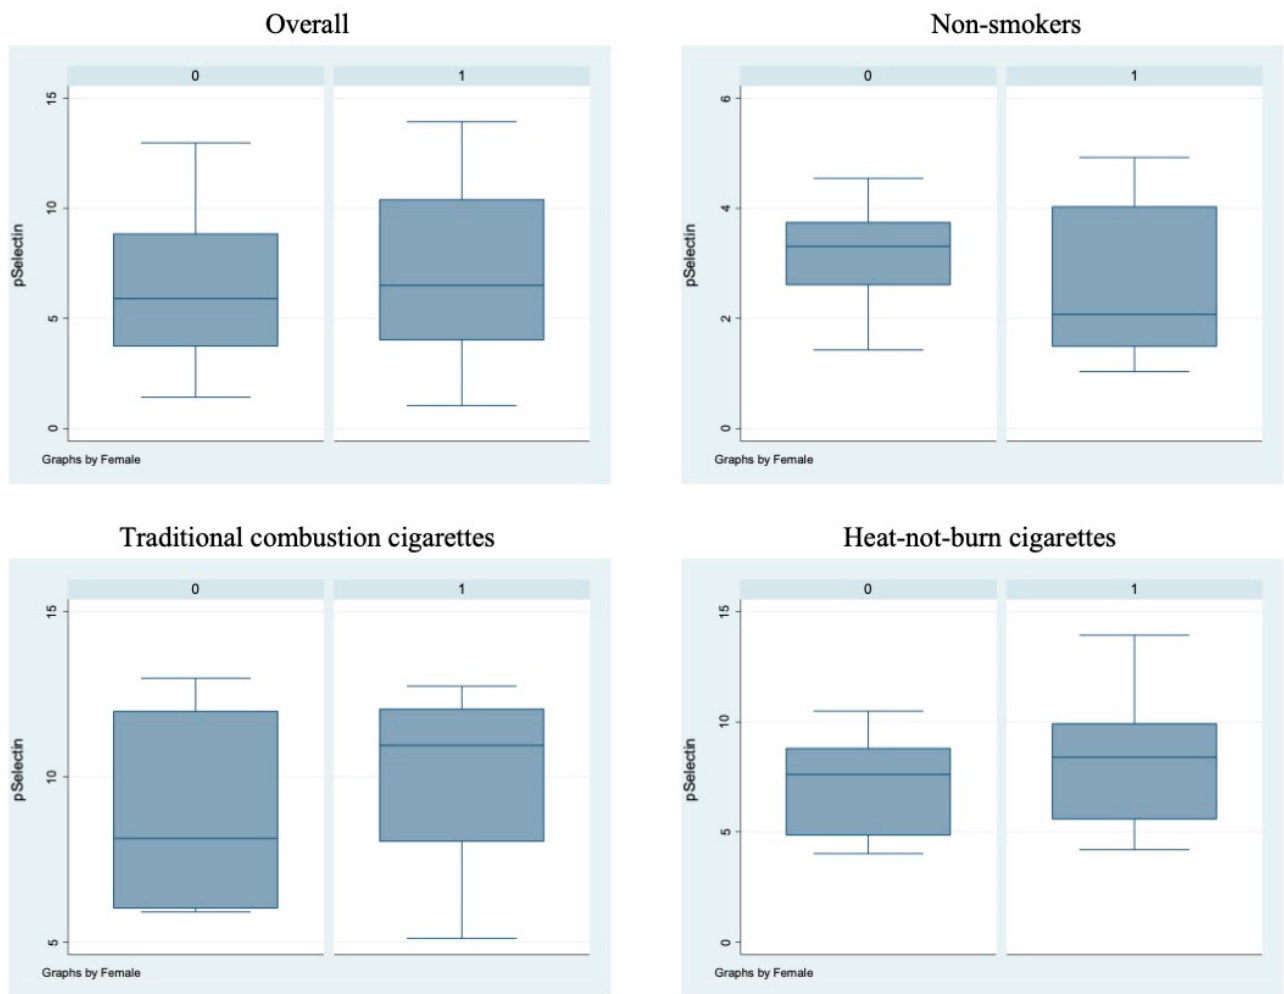
Figure 3. sP-selectin circulating levels in the different sub-populations. Box-and-whisker plots representing sP-selectin circulating levels (ng/mL) in the overall cohort and in non-smokers, TCCs- smokers and HNBCs-smokers subgroups. 0 = males; 1 = females